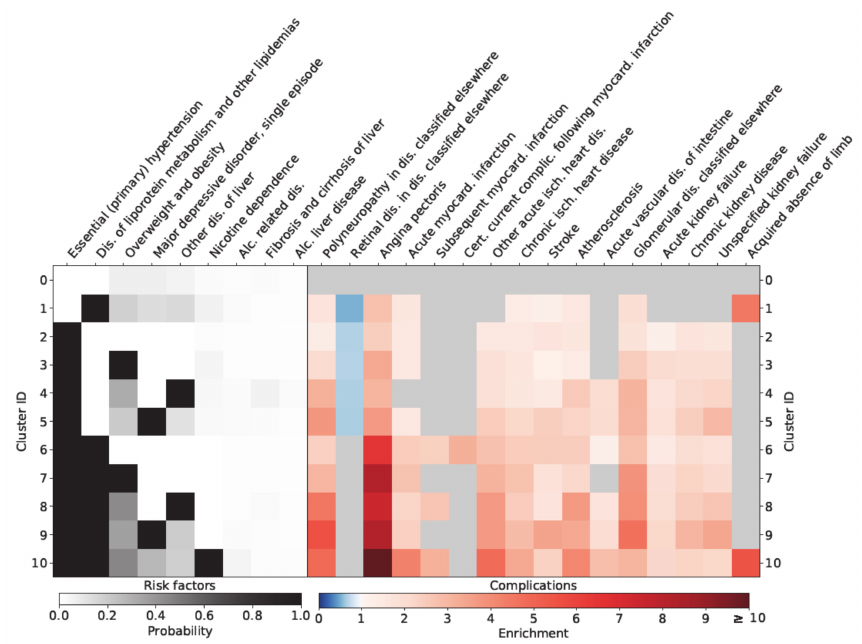
Figure 2. Relationship of different clusters with typical diabetes-specific complications in